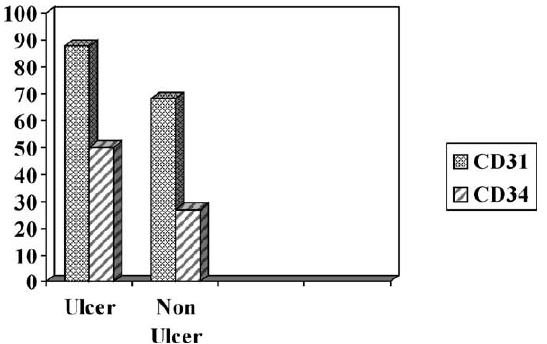
Fig. 5. CD31 and CD34 expression in ulcerated vs non ulcerated Clark’s level III–V melanomas: graphic representation showing the percentages of immunolabeled